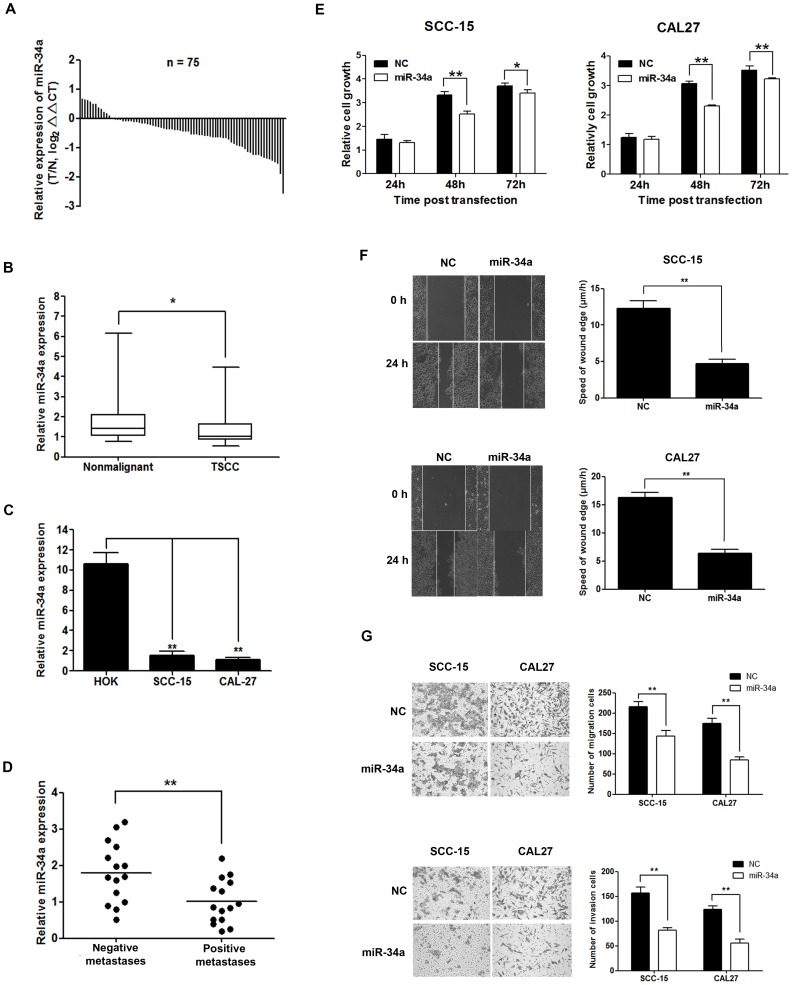
miR-34a correlated with lymph node metastases of TSCC patients and inhibited migration and invasion of TSCC cell lines.(A), Relative levels of miR-34a in 75 surgical specimens of TSCC and matched adjacent nonmalignant tissues was quantified by qRT-PCR. Data were presented as log2 fold change(△△Ct values,TSCC/Nonmalignant, T/N). (B), Means of miR-34a relative levels for 75 surgical specimens of TSCC and the matched adjacent nonmalignant tissues. Data were presented as 2−△Ct (miR-34a-U6) values (*P<0.05). (C), Means of miR-34a relative levels in SCC-15, CAL27 cell lines and primary normal human oral keratinocyte (HOK) cells. Data were presented as 2−△Ct (miR-34a-U6) values (**P<0.01). (D), Means of miR-34a relative levels from formalin-fixed paraffin-embedded tissues including a group of 15 TSCC patients with positive lymph node metastases compared with another group of 15 TSCC patients with negative lymph node metastases matched for age, gender, pathologic differentiation, and TNM stage. Data were presented as 2−△Ct (miR-34a-U6) values (**P<0.01). (E), Cell viability was measured using CCK-8 assays, the data were presented as means ±SD as indicated (*P<0.05, **P<0.01). (F) and (G) Representative photomicrographs of wound healing and transwell assays results for SCC-15 and CAL27 cells transfected with pcDNA3.0-miR-34a (miR-34a) or pcDNA3.0 (NC) (×200 magnification, **P<0.01).